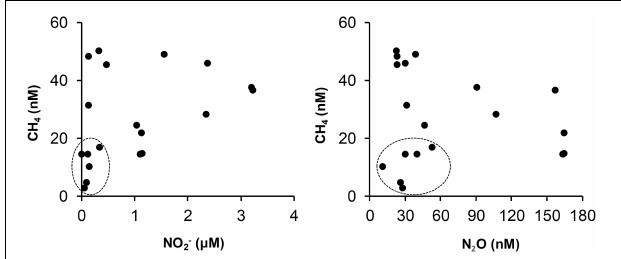
FIGURE 7 | Relationship between CH 4 concentrations and transient denitrified products in the nearshore regions during SM. Circled points depicting lowest concentrations correspond to Mangalore during